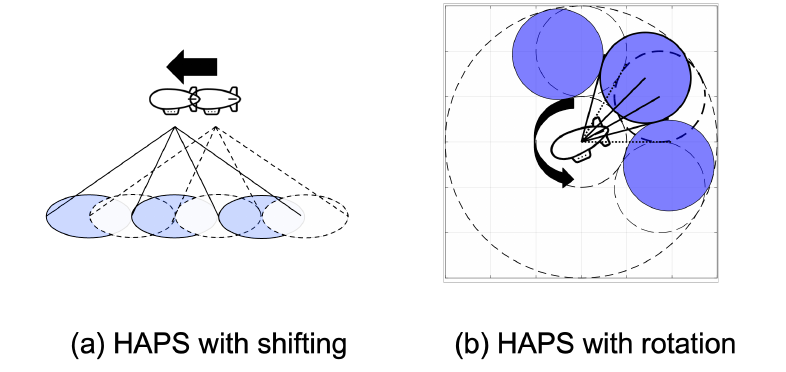
Figure 2. Movement